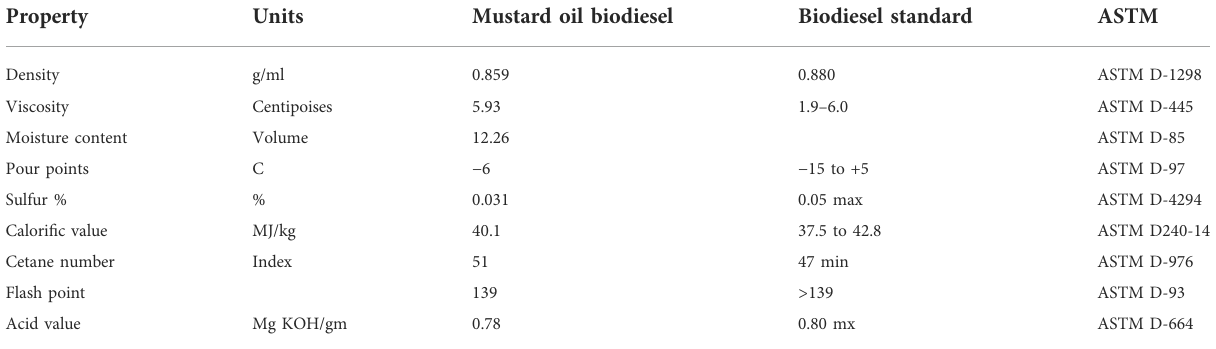
TABLE 6 Fuel parameters of